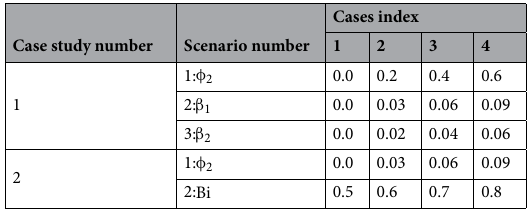
Table 1. Physical parameter settings of the